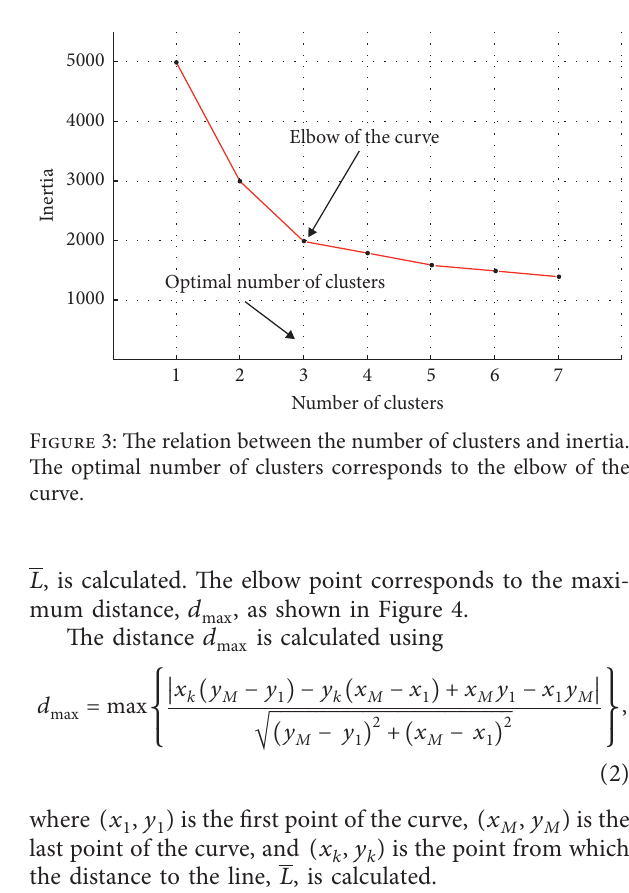
Figure 2: The distribution of Parkinson’s disease dataset against (a) age, (b) gender, (c) age of disease onset (years), and (d) duration of disease from first symptoms (years).